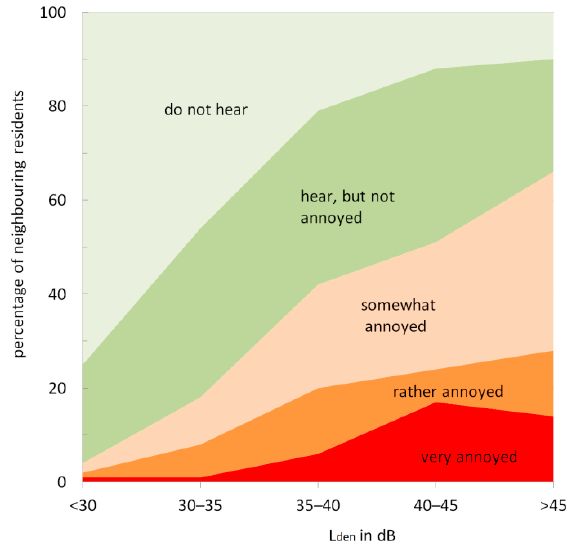
Figure 1. Reactions to wind turbine noise.